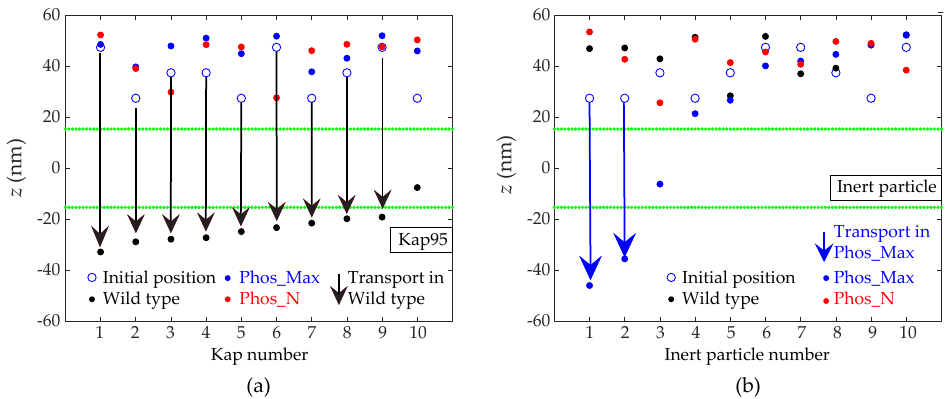
Figure 7. Effect of phosphorylation on active ( a ) and passive ( b ) transport. In both cases, the particles are released from the same position at the cytoplasmic side and are ordered from left to right based on the end position at t = 2 µ s. ( a ) Initial ( t = 0 µ s) and final ( t = 2 µ s) axial ( z ) position of ten Kap95 particles, and ( b ) Initial ( t = 0 µ s) and final ( t = 2 µ s) axial ( z ) position of ten inert particles of the same size as the Kap95 particles (diameter = 8.5 nm, no charge and no hydrophobic binding spots). In both ( a ) and ( b ), the boundaries of the NPCs (| z | = 15.5 nm) are represented by green lines and the arrows represent translocations from the cytoplasm to the nucleoplasm.